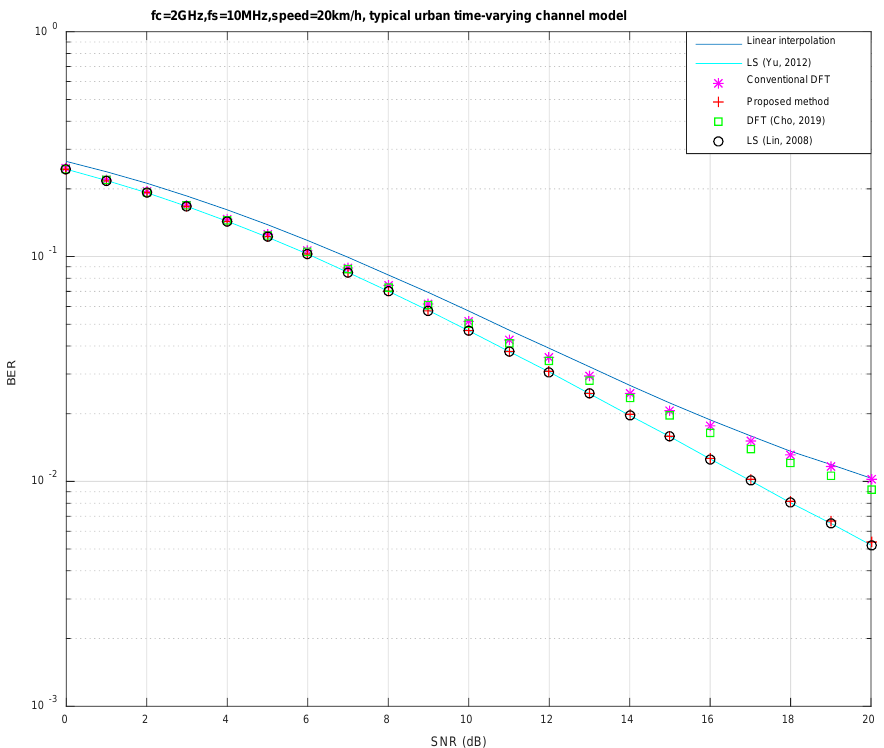
Figure 2. Simulated diagram of SNR to error rate when the carrier frequency is 2 GHz, the sampling frequency is 10 MHz, and the speed is 20 km/h for typical urban time-varying channel model [8,10,11]. Figures 3 and 4 show the simulation results with speeds equal to 100 km/h and 200 km/h, respectively. At low SNR, the six curves did not change from Figures 2–4 as the effect of noise was higher than speed. At high SNR, the six curves from Figures 2–4 all deteriorated with increasing speed as the effect of speed was higher than noise. Since the channel changes were extraordinarily slow, it can be assumed that the channel is approximately invariant within an OFDM symbol when speed is very low. The channel was no longer approximately invariant within an OFDM symbol when the speed is very high. Therefore, the simulation results at high speed are worse than the simulation results at low speed when SNR is high. The BER curves of the LS methods [10,11] and the method proposed in this paper are still overlapped in Figures 3 and